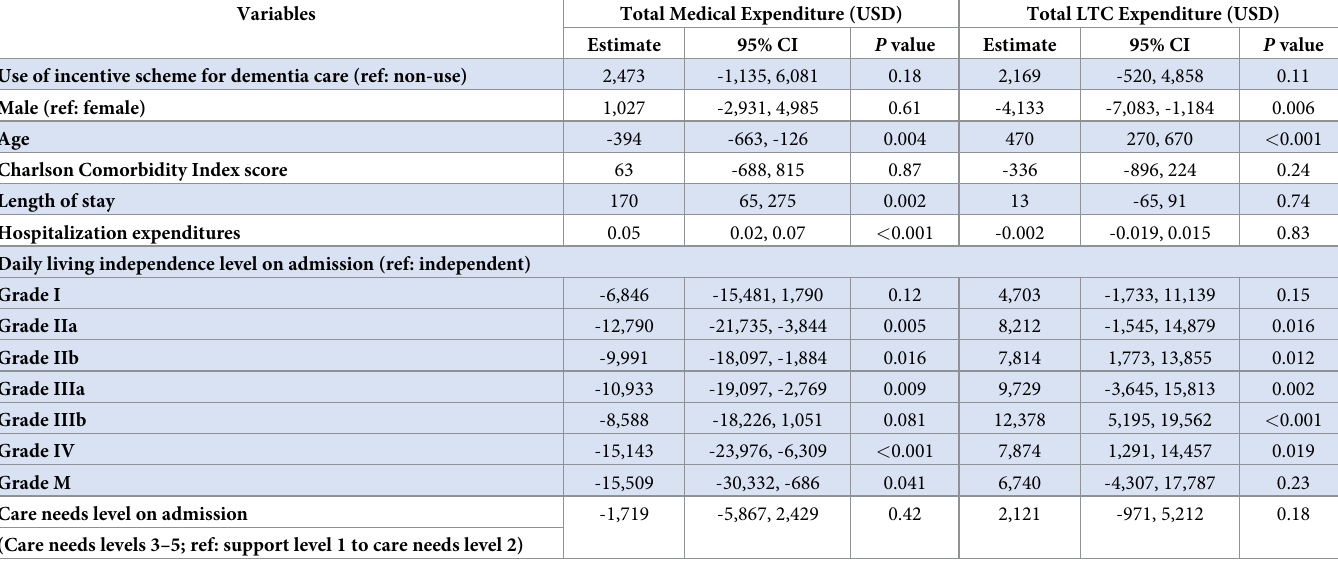
Table 3. Multivariable linear regression analyses of total medical and LTC expenditures for one year after discharge. Variables